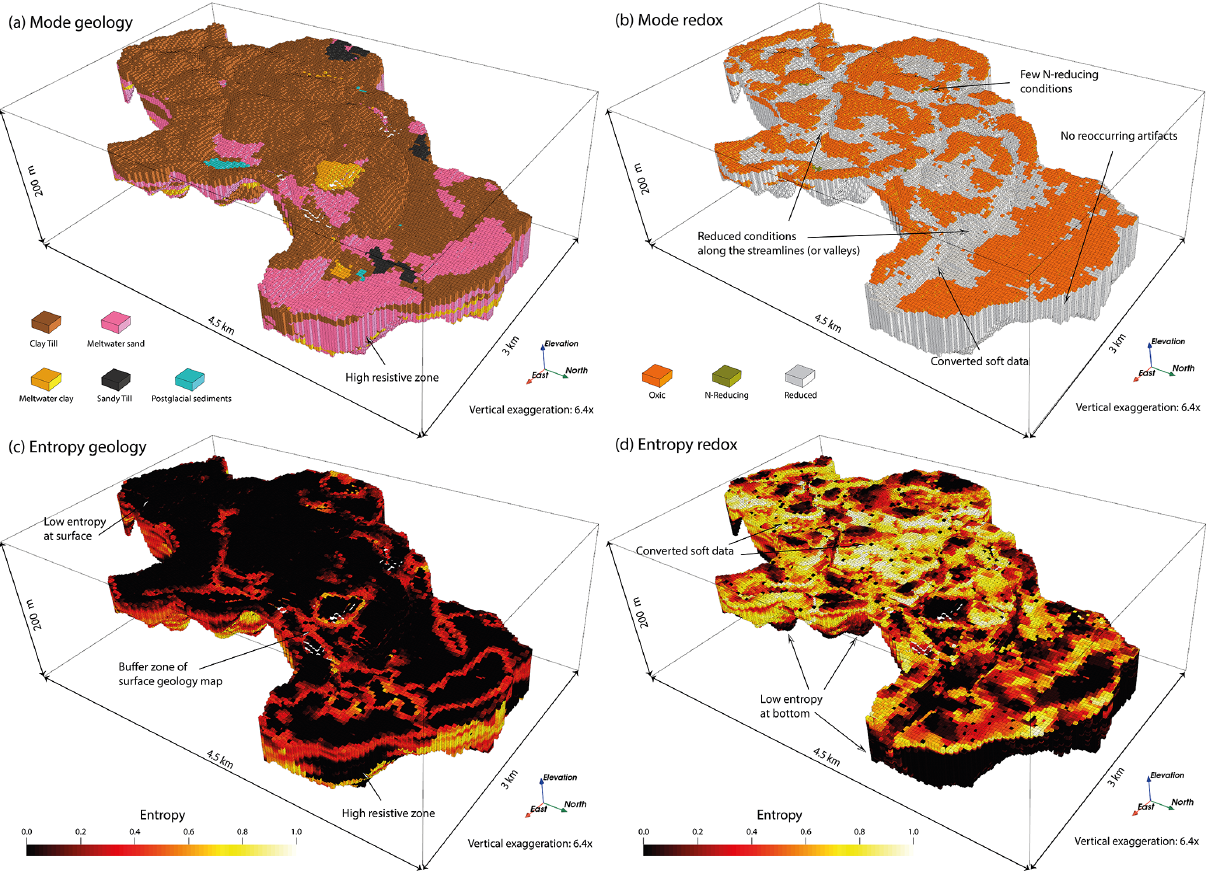
Figure 14. Mode and entropy of 100 geology and redox realizations. Low entropy (certainty) is marked with black color, while white colors represent high entropy